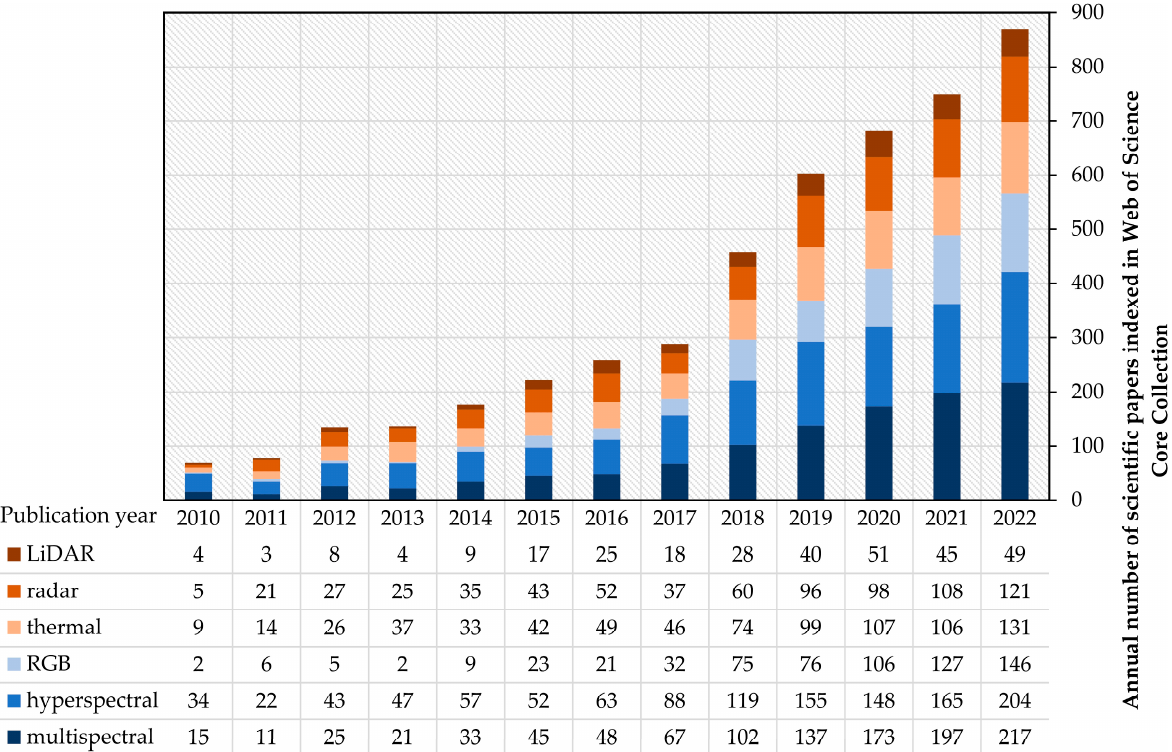
Figure 5. The number of scientific papers indexed in WoSCC since 2010 with the topic of “precision agriculture” AND particular sensor type.